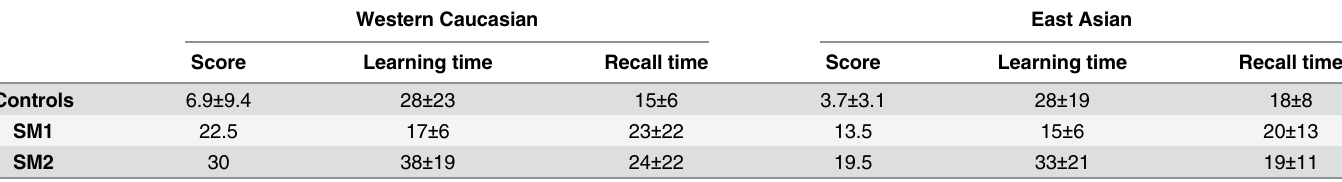
Table 3. Results for Experiment 2: Western Caucasian and Eastern Asian face-name